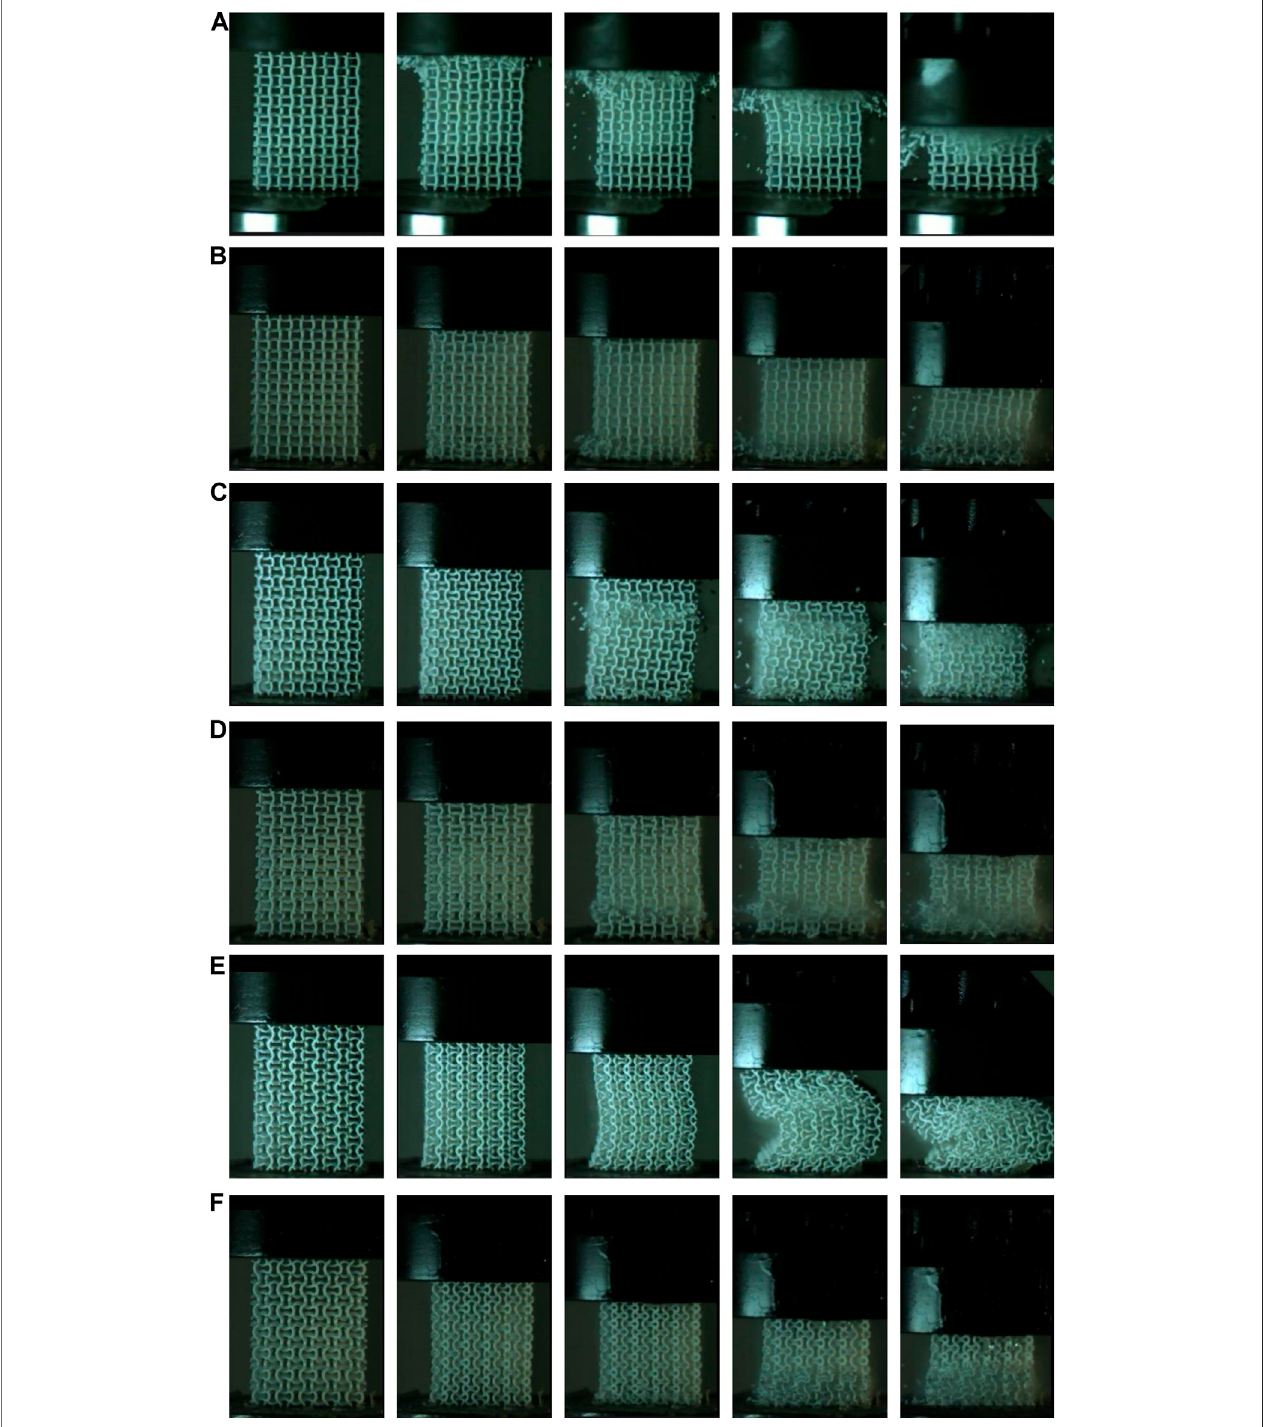
FIGURE11| Thetypical damagepatterns fortheNPRfoams:specimenCCF1 (A) _ ε (cid:2) 71.4 s − 1 and (B) _ ε (cid:2) 2.14 × 10 2 s − 1 ;specimenCCF2 (C) _ ε (cid:2) 71.4 s − 1 and (D) _ ε (cid:2) 2.14 × 10 2 s − 1 ; specimen CCF3 (E) _ ε (cid:2) 71.4 s − 1 and (F) _ ε (cid:2) 2.14 × 10 2 s − 1 .